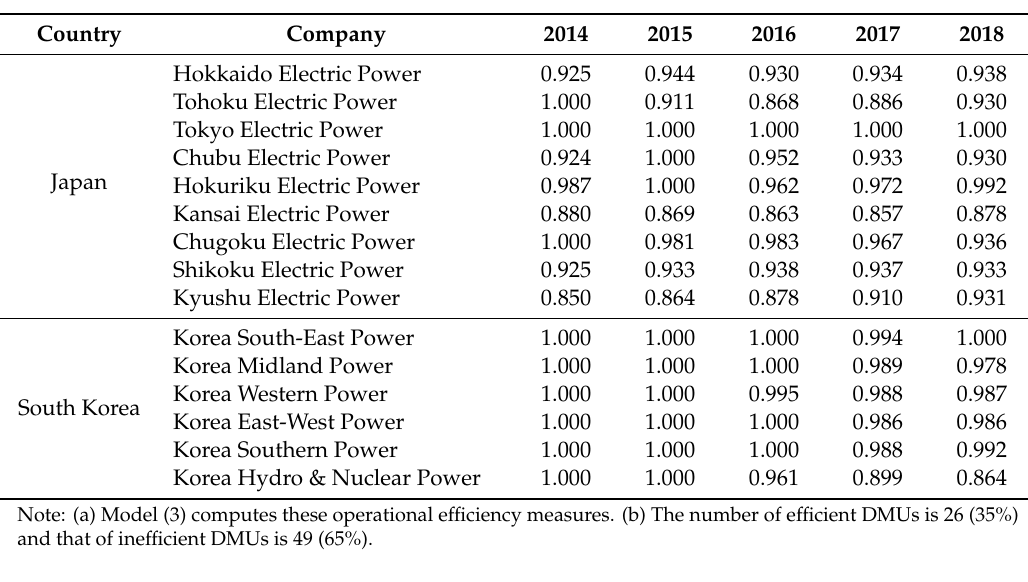
Table 6. E ffi ciencies of Japanese and Korean Power Companies.